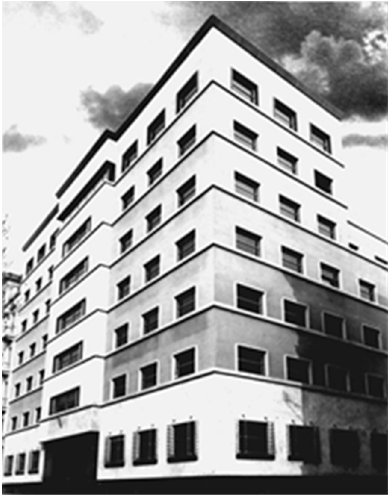
Figure 3. Palazzo Gualino offices of Giuseppe Pagano Pogatschnig and Gino Levi Montalcini. Turin (1928–1930). Photo from (Danesi and Patetta 1976).